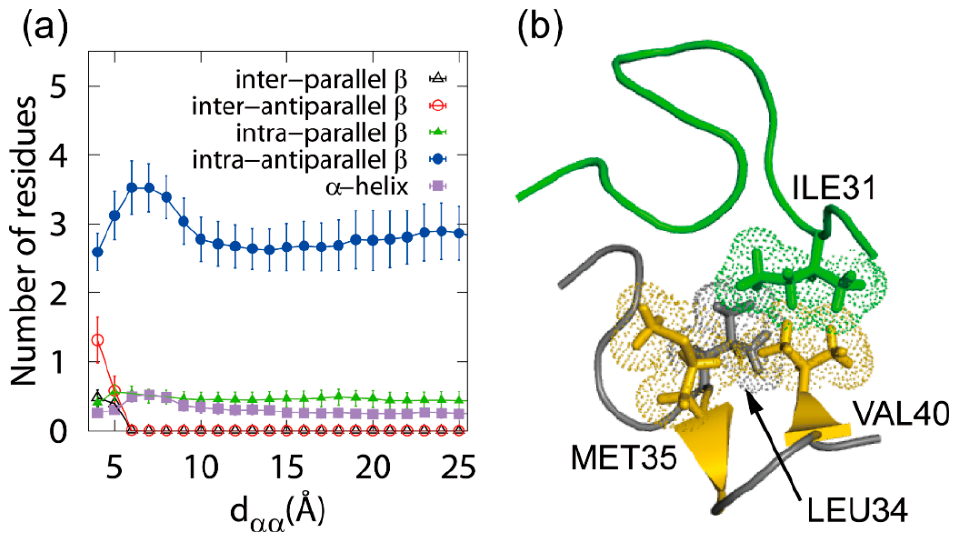
Figure 3. ( a ) The number of amino acid residues forming each secondary structure as a function of the intermolecular C α –C α distance d αα between the two A β (29–42) peptides. ( b ) A typical β -hairpin structure of A β (29–42). Reprinted with permission from Ref. [36]. Copyright 2014 American Chemical Society.